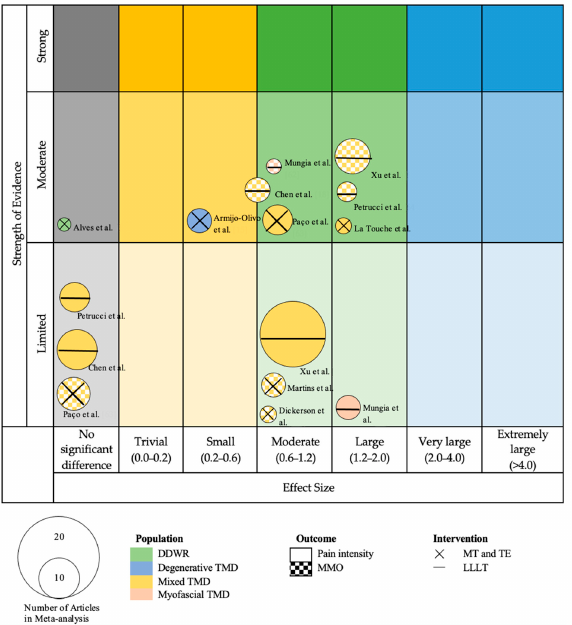
Figure 3. Mapping based on effect size of MMA and strength of the evidence. On the x-axis, the studies are classified according to the effect size of the meta-analysis with standard mean difference (SMD). On the y-axis, they are categorized according to the strength of evidence based on the Phys- ical Activity Guidelines Advisory Committee (PAGAC) [15,18,19,57,60–64,67]. Green bubble: Disc displacement with reduction; blue bubble: degenerative temporomandibular disorder; yellow bub- ble: mixed temporomandibular disorder; orange bubble: myofascial temporomandibular disorder; X: manual therapy and therapeutic exercise; − : low-level laser therapy.